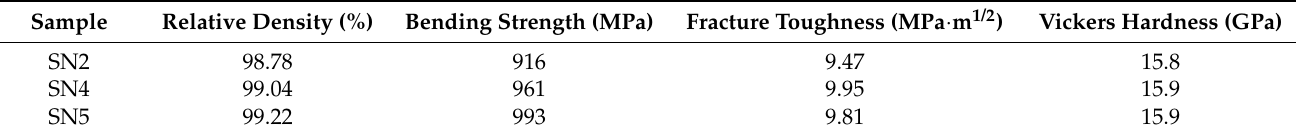
Table 3. Effect of hot-pressing temperature on the mechanical properties of materials.